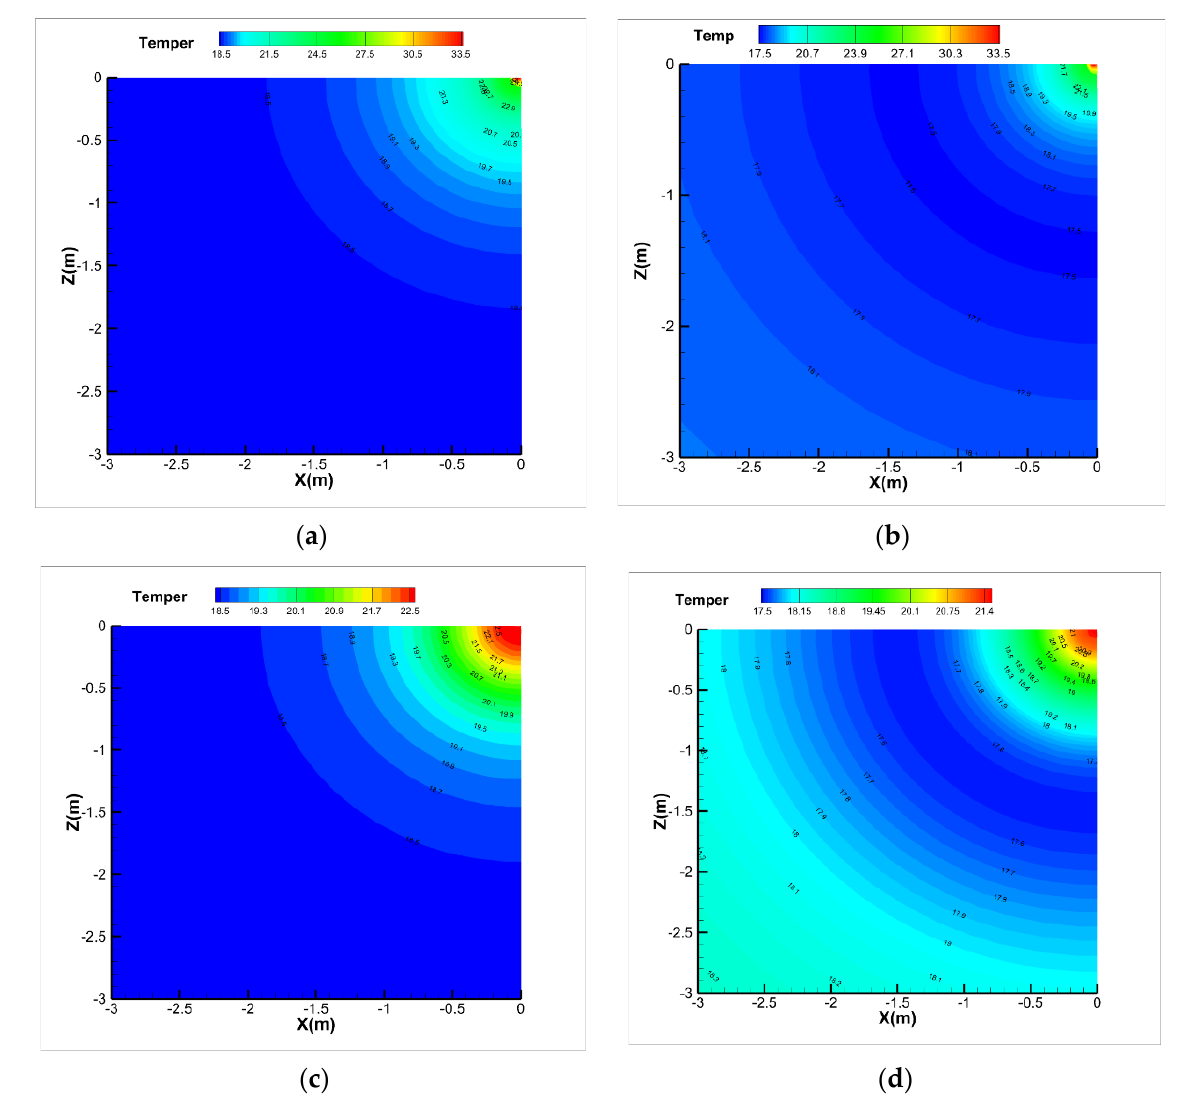
Figure 5. The simulation results of the soil temperature (at the center cross-section of 41 m depth) field at the end of the operation and recovery period during the discharging process with and without precooling, respectively. ( a ) Operation period end without precooling (Case 1); ( b ) Operation period end with precooling (Case 5); ( c ) Recovery period end without precooling (Case 1); ( d ) Recovery period end with precooling (Case 5).